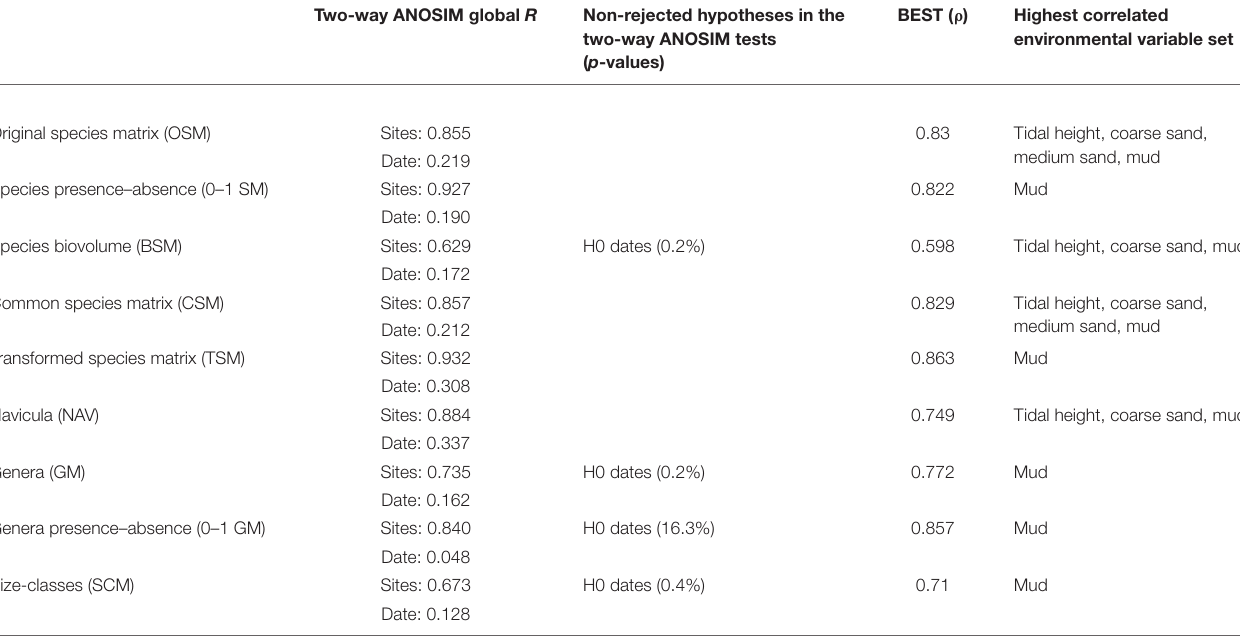
TABLE 3 | Comparison of different approaches used to study the multivariate structure of the diatom communities. Two-way ANOSIM global R Non-rejected hypotheses in the two-way ANOSIM